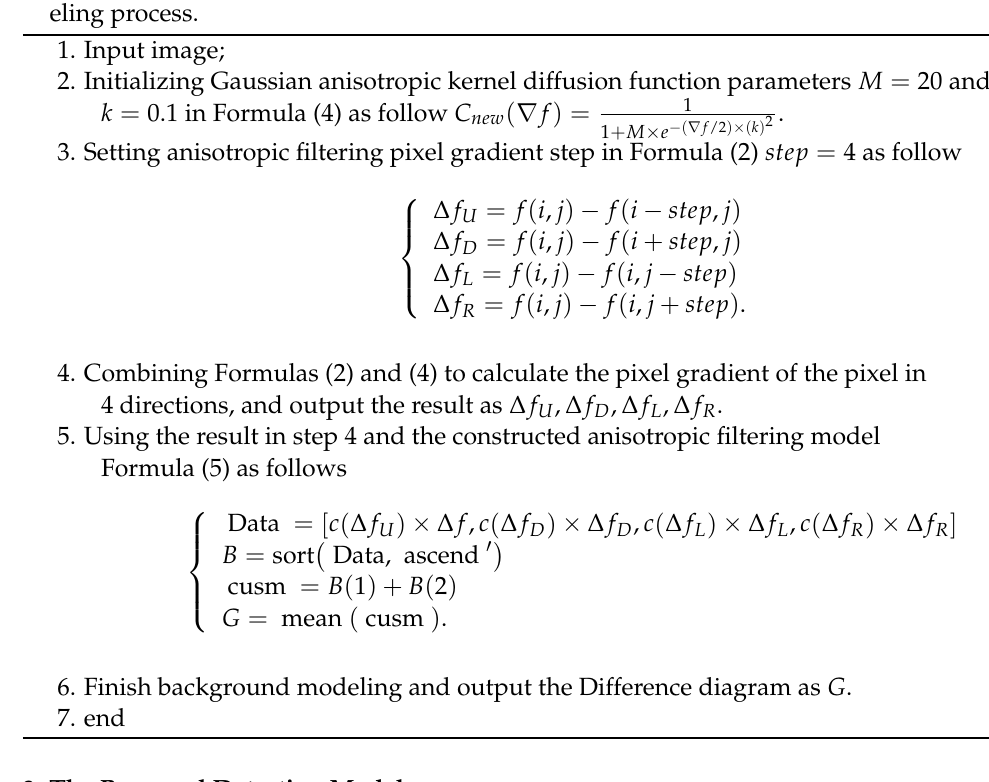
Algorithm 1: Anisotropic Gaussian kernel diffusion function background